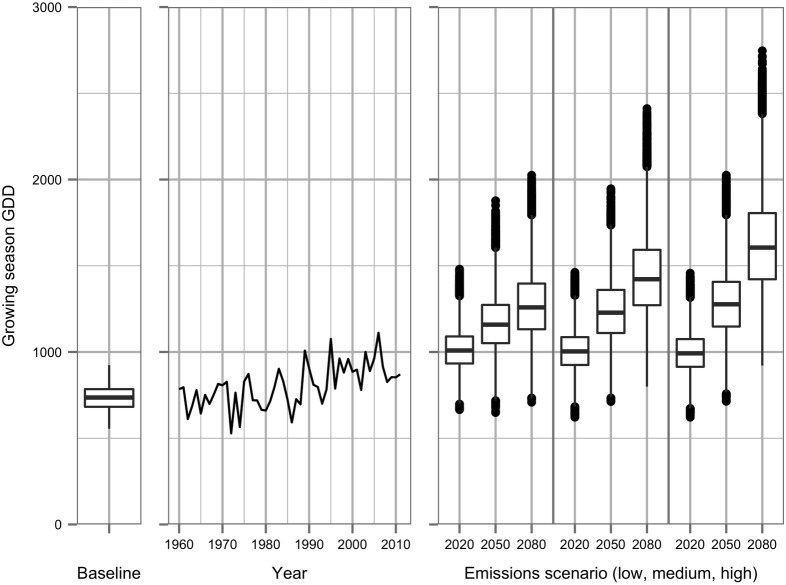
Changes in cumulative growing season GDD (1st April to 31st October) calculated from baseline (1960–90) weather generator runs, daily historic weather data (1960–2011) and future climate weather generator runs using three emissions scenarios (low, middle and high emissions from left to right) and time periods.Baseline quantile box plots calculated from 9,000 30-year time sequences; future box plots from 1,000 30-year time sequences.